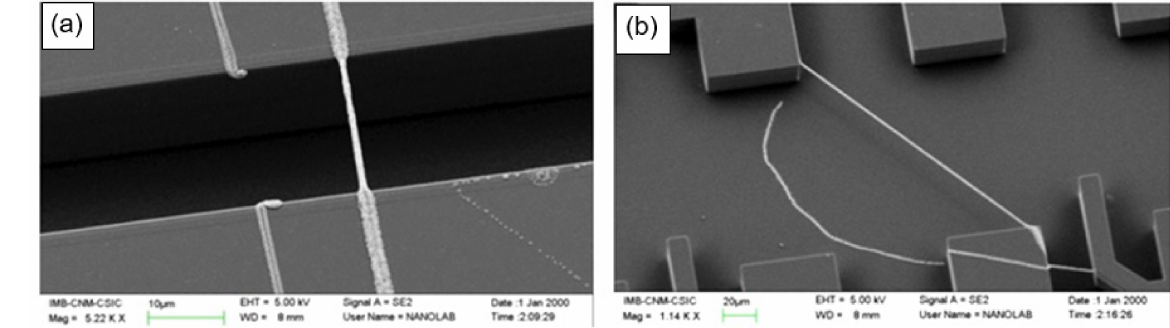
Figure 3. Electrospun ZnO nanobridges with lengths from ( a ) 20 µ m to ( b ) 150 µ m. A broken fiber is depicted to show that bridge formation is not a trivial process and the temperature ramp affects sintering. Reprinted from